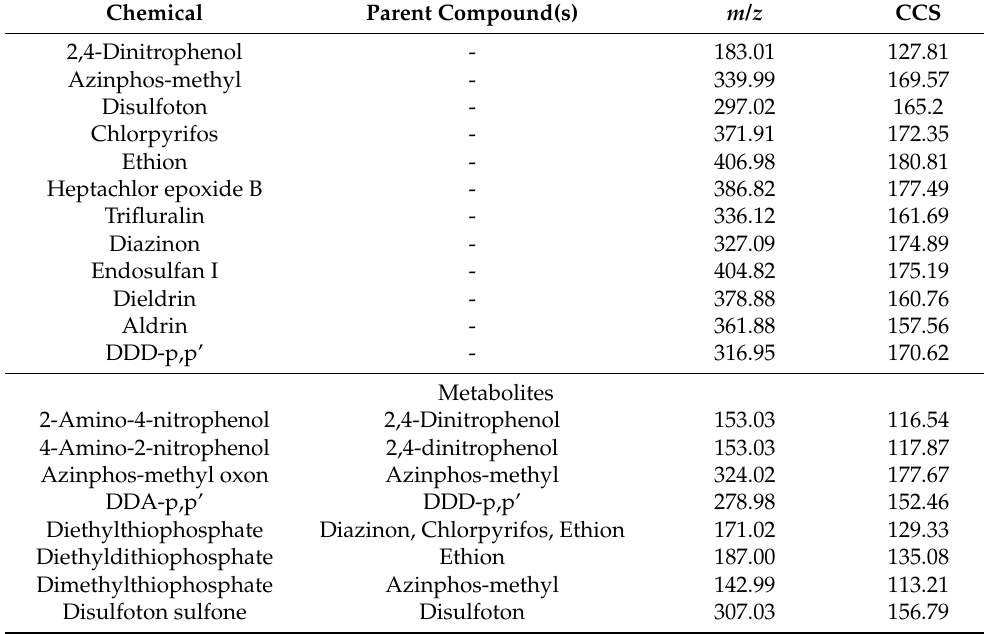
Table 2. Chemicals detected with